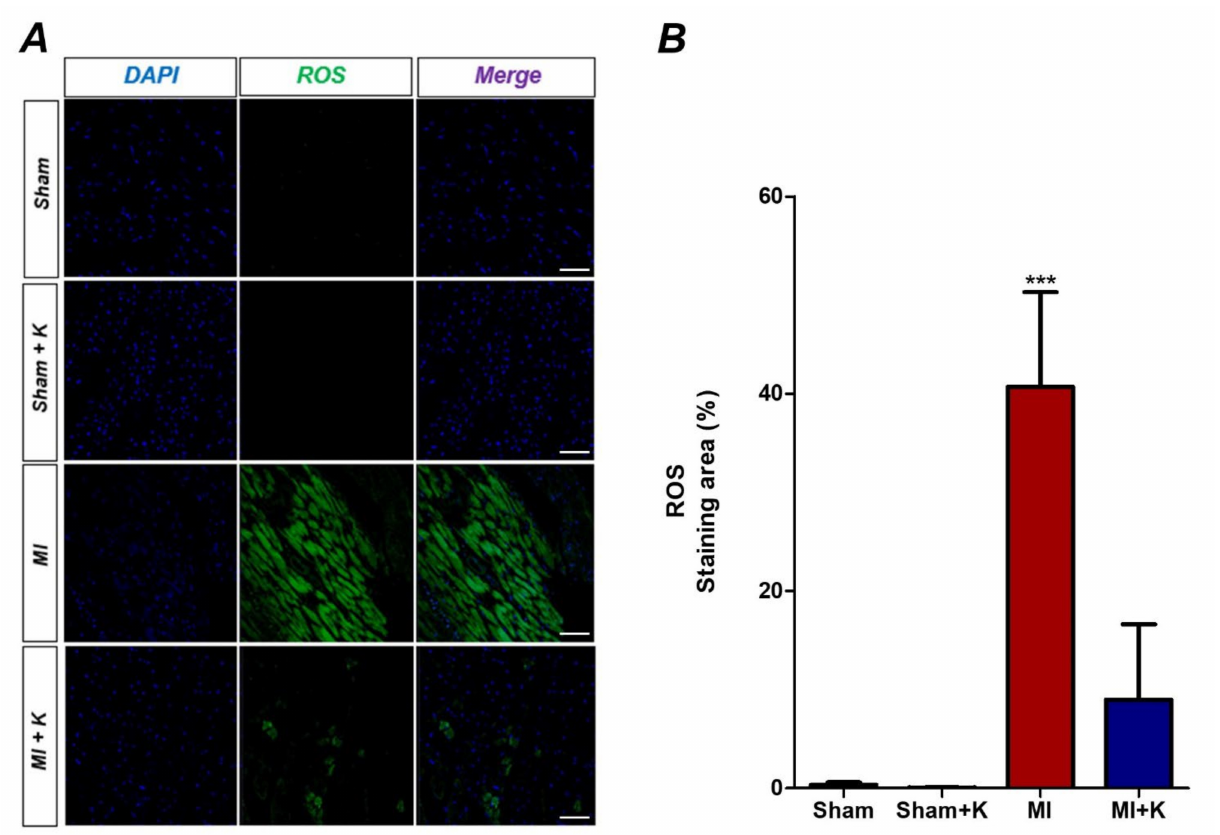
Figure 2. Intracellular reactive oxygen species (ROS) level. ( A ) Representative intracellular reac- tive oxygen species (ROS) results observed following administration of klotho after myocardial ischemic/reperfusion (I/R) injury; ( B ) ROS staining area, *** p < 0.001, comparison of myocardial I/R with and without administration of recombinant klotho (rKL) by one-way analysis of variance (ANOVA) followed by Bonferroni post hoc test (number of animals: n = 5). Scale bar, 50 µ